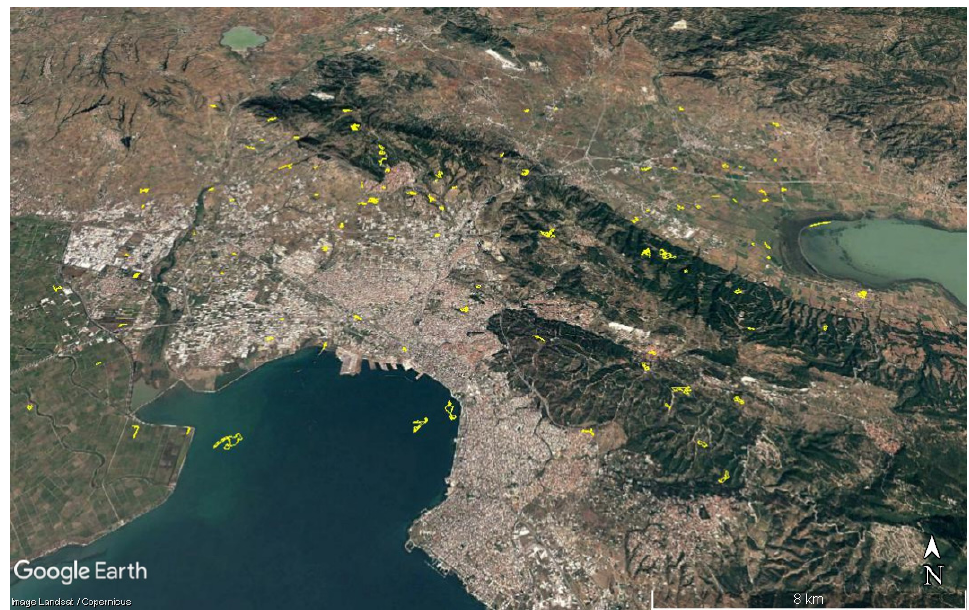
Figure 3. Testing samples (yellow polygons) selected randomly from the 75-scale segmentation layer imposed onto the Google Earth image background.